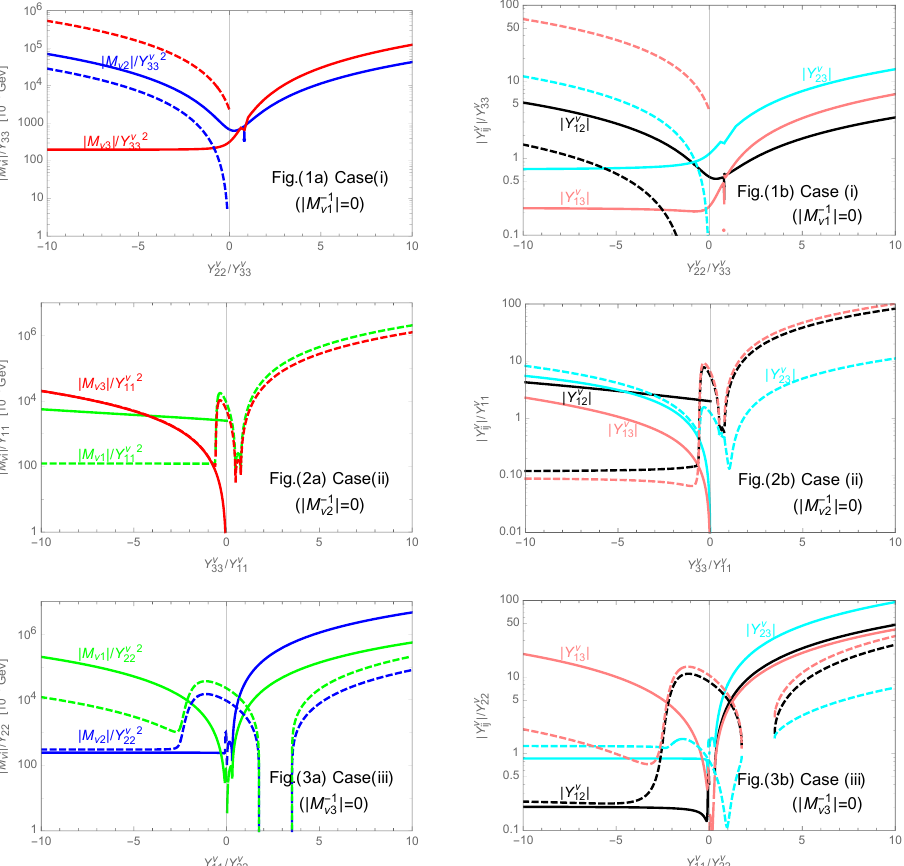
Figure 7 . The Majorana mass terms and the Dirac neutrino Yukawa couplings, when Y (cid:23) hermitian matrix and the Majorana phases in ^ m (cid:23) are vanishing. In (cid:12)gure (1a), (cid:12)gure (2a) and (cid:12)gure (3a), the red, blue and green (dashed) line correspond to the M (cid:23) normal (inverted) ordering. In (cid:12)gure (1b), (cid:12)gure (2b) and (cid:12)gure (3b), the sizes of Y (cid:23) (pink), Y (cid:23) (cyan) are shown, in the cases (i), (ii) and (iii), 23